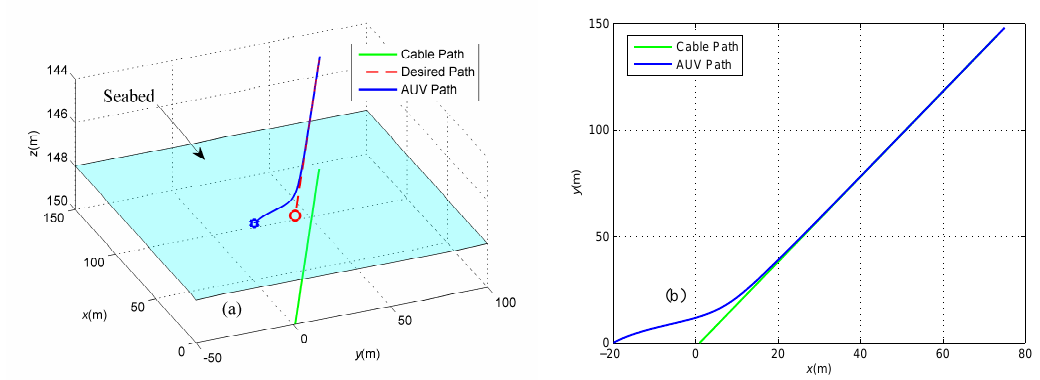
Figure 7. ( a ) Three-dimensional view of the cable tracking; and ( b ) Two-dimensional projection in the X - Y plane. These two pictures intuitively describe the cable tracking process, where the green line represents the underwater cable, the red dashed line represents the desired tracking path and the blue line represents the actual path of the under-actuated